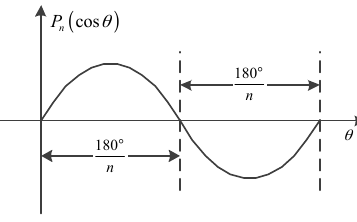
Figure 2. One period of function P n (cos θ ).